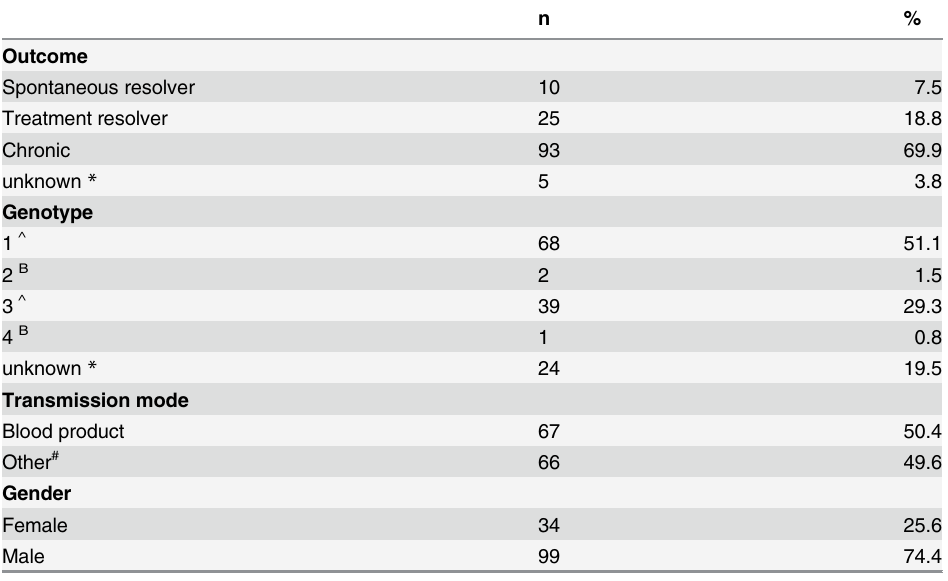
Table 1. Subject demographics and clinical